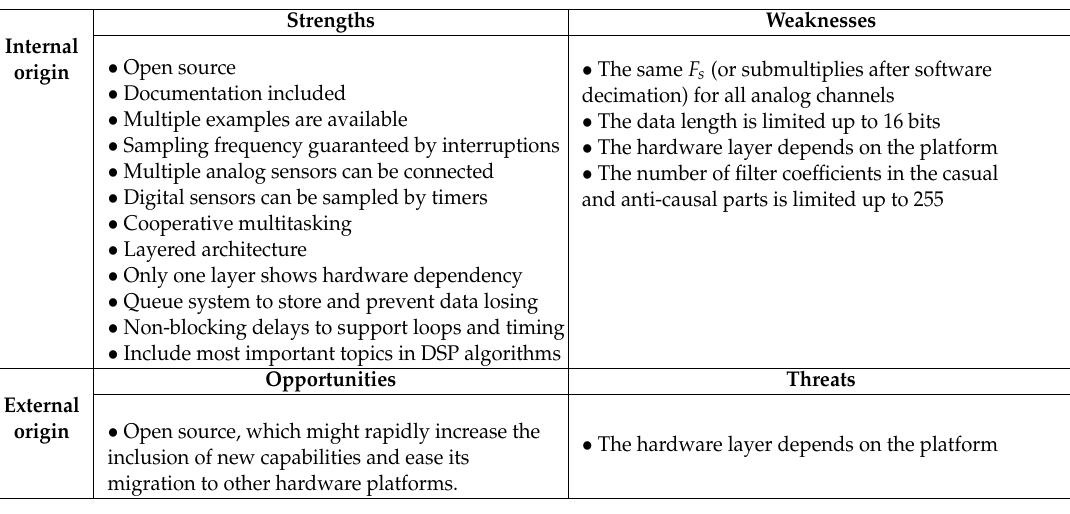
Table 1. SWOT analysis applied to the software